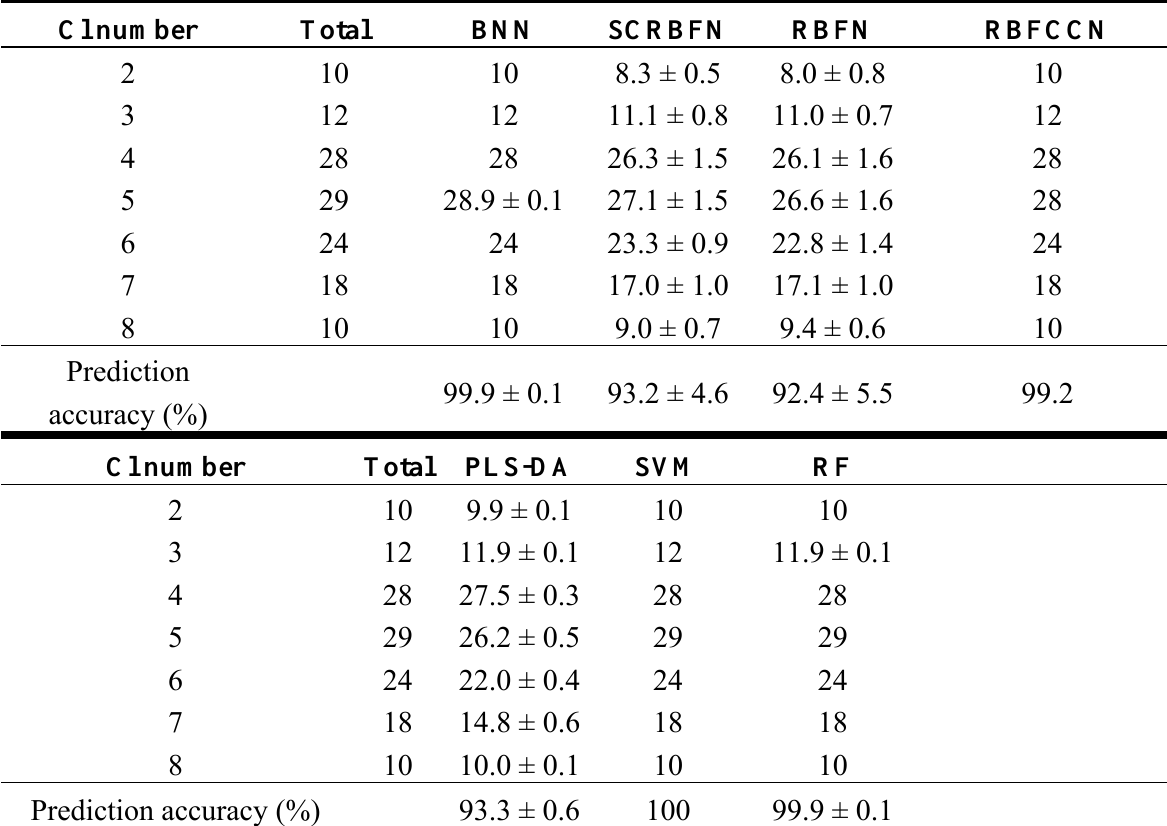
Table 8. Average numbers of correctly predicted spectra with 95% confidence intervals of PCB data set by different modeling methods with 30